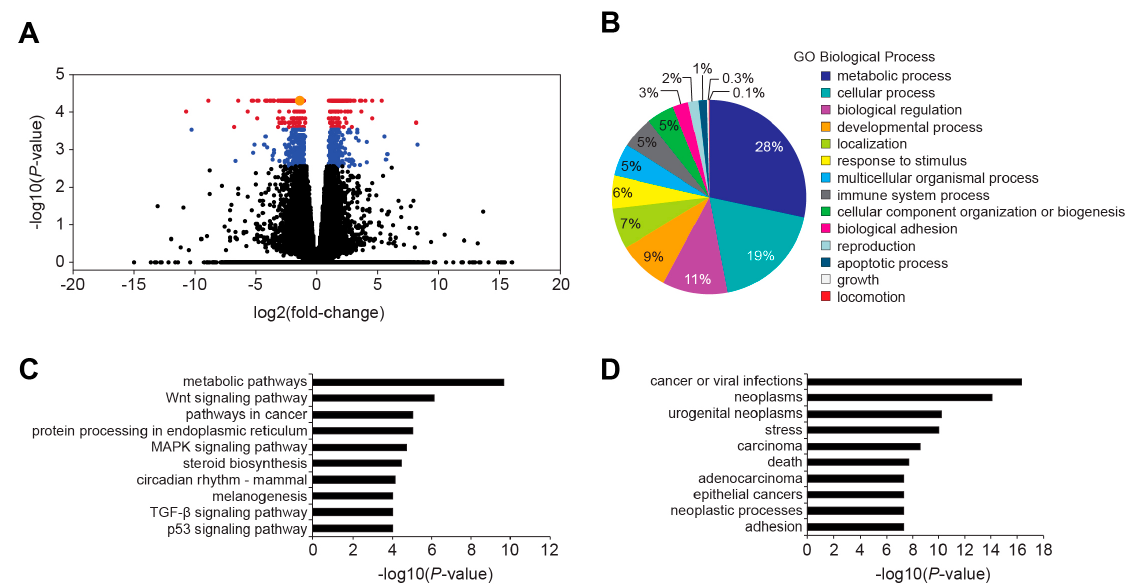
Figure 4. Transcriptome analysis of 3 ′ WRE ‐ Mut cells. ( A ) Volcano plot showing the log2 (fold ‐ change) for transcripts isolated from 3 ′ WRE ‐ Mut cells relative to control cells versus the − log10 ( p ‐ value). A total of 949 genes (blue) were differentially expressed at a q ‐ value of < 0.05 and 448 genes (red) were differentially expressed at a q ‐ value of <0.01. MYC is denoted as an orange circle; ( B ) Gene Ontology (GO); ( C ) Kyoto Encyclopedia of Genes and Genomes (KEGG); and ( D ) disease enrichment analyses of genes that were differentially expressed in 3 ′ WRE ‐ Mut versus control cells.